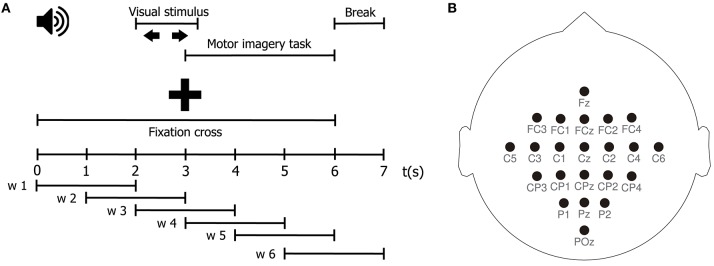
(A) Schematic representation of the MI protocol. (B) EEG channel montage used for the acquisition of the MI dataset.